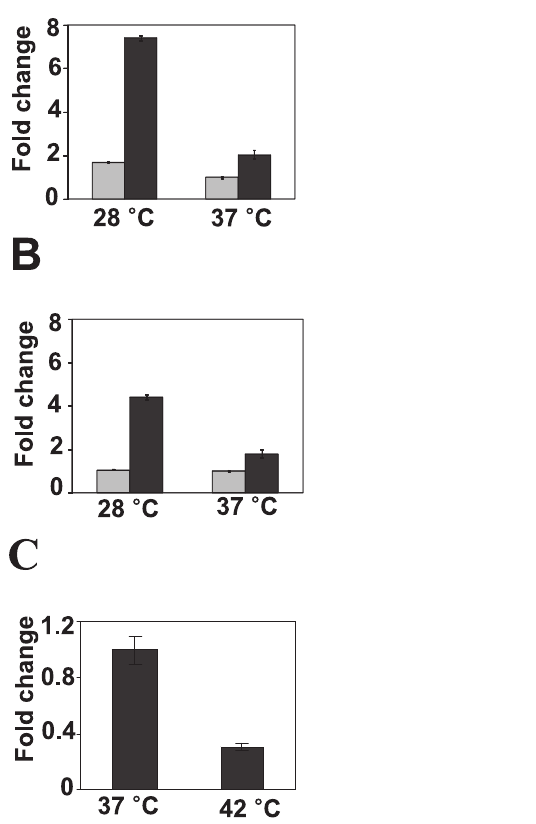
Figure 8. Expression of ybjN gene in E. coli strain BW25113 strain. A and B. Relative expression level of ybjN in LB broth (A) and M9 medium (B). Dark bar: log phase, Light bar: stationary phase. The expression of ybjN was measured by qRT-PCR, normalized to the expression value of 16S rRNA ( rrsA ) gene and then compared to ybjN expression level at stationary phase at 37 u C in M9 medium. Bacterial cells were collected in LB or M9 medium at an OD 600 at 0.8 , 1.0 for log phase and 1.8 , 2.1 for stationary phase. C. Relative expression level of ybjN at high temperature. Bacterial cells were grown to log phase in M9 at 37 u C and then incubated with shaking at 37 u C or 42 u C for 6 h. The relative expression of ybjN at 42 u C was measured by qRT-PCR, normalized to the expression value of rrsA gene and then compared to the ybjN expression level at 37 u C.